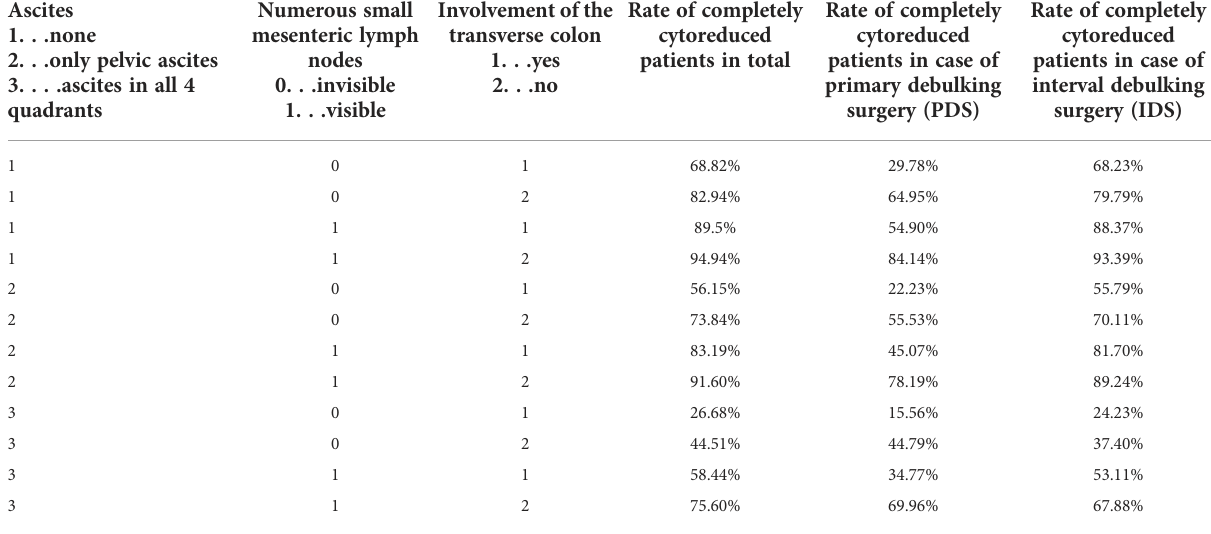
TABLE 3 Multivariate binary logistic regression analysis of 14 signi fi cant variables in FIGO IIIA – IVB patients. Ascites 1. .